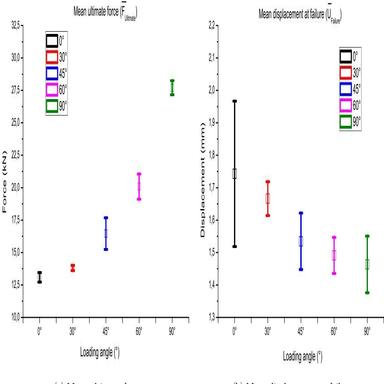
Effect of the loading angle ψ (a) Mean ultimate force and (b) Mean displacement at failure.